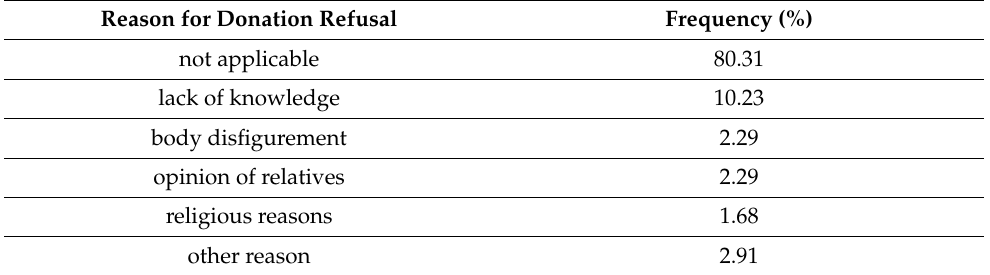
Table 5. Reasons for donation